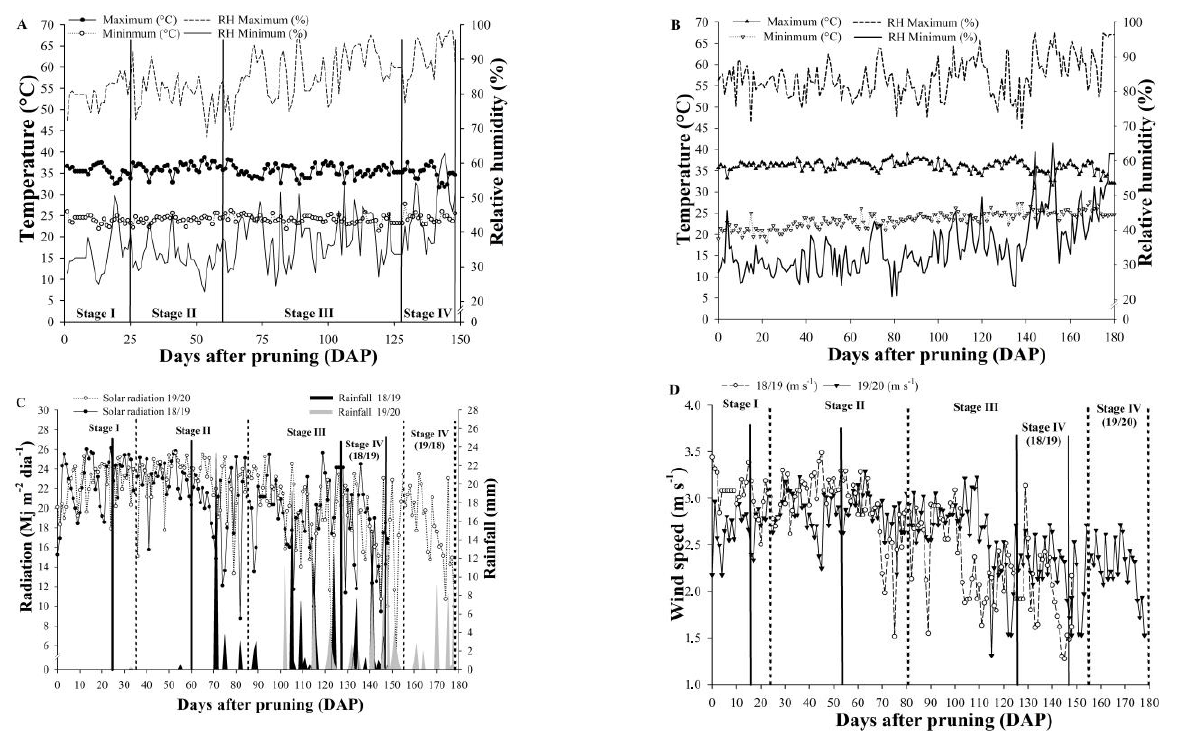
Figure 1. Climatic data collected during the experimental period (from 2018/2019 to 2019/2020).